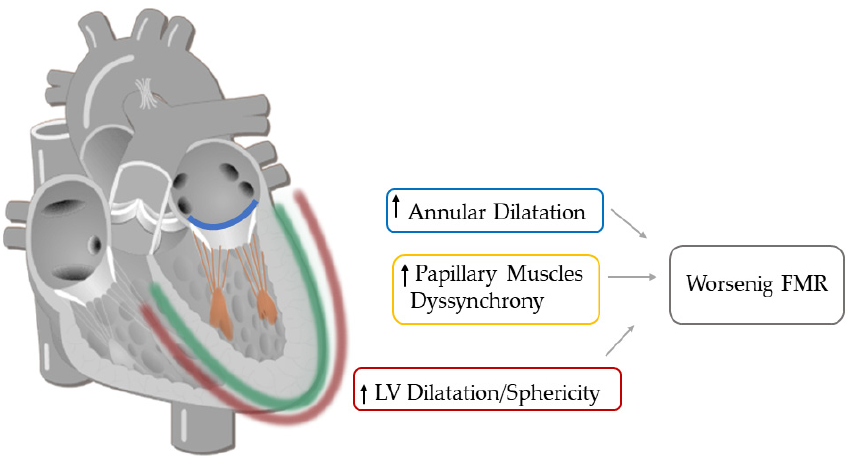
Figure 1. Exercise-induced dynamic geometric changes in the LV and mitral valve apparatus thus causing MR worsening.